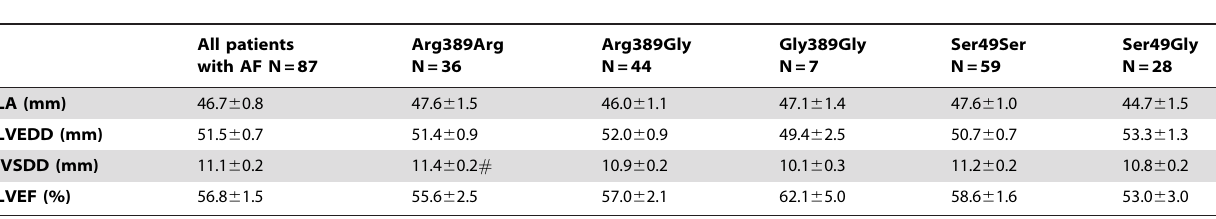
Table 2. Echocardiographic values in patients with different b 1 AR